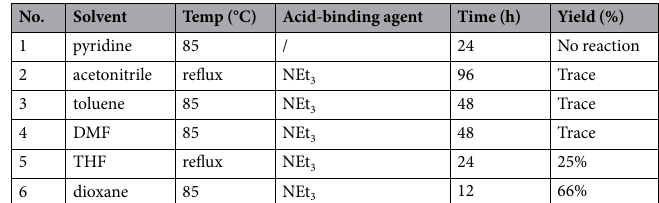
Table 1. Effects of Different Solvents for Synthesis of Compound I-2.